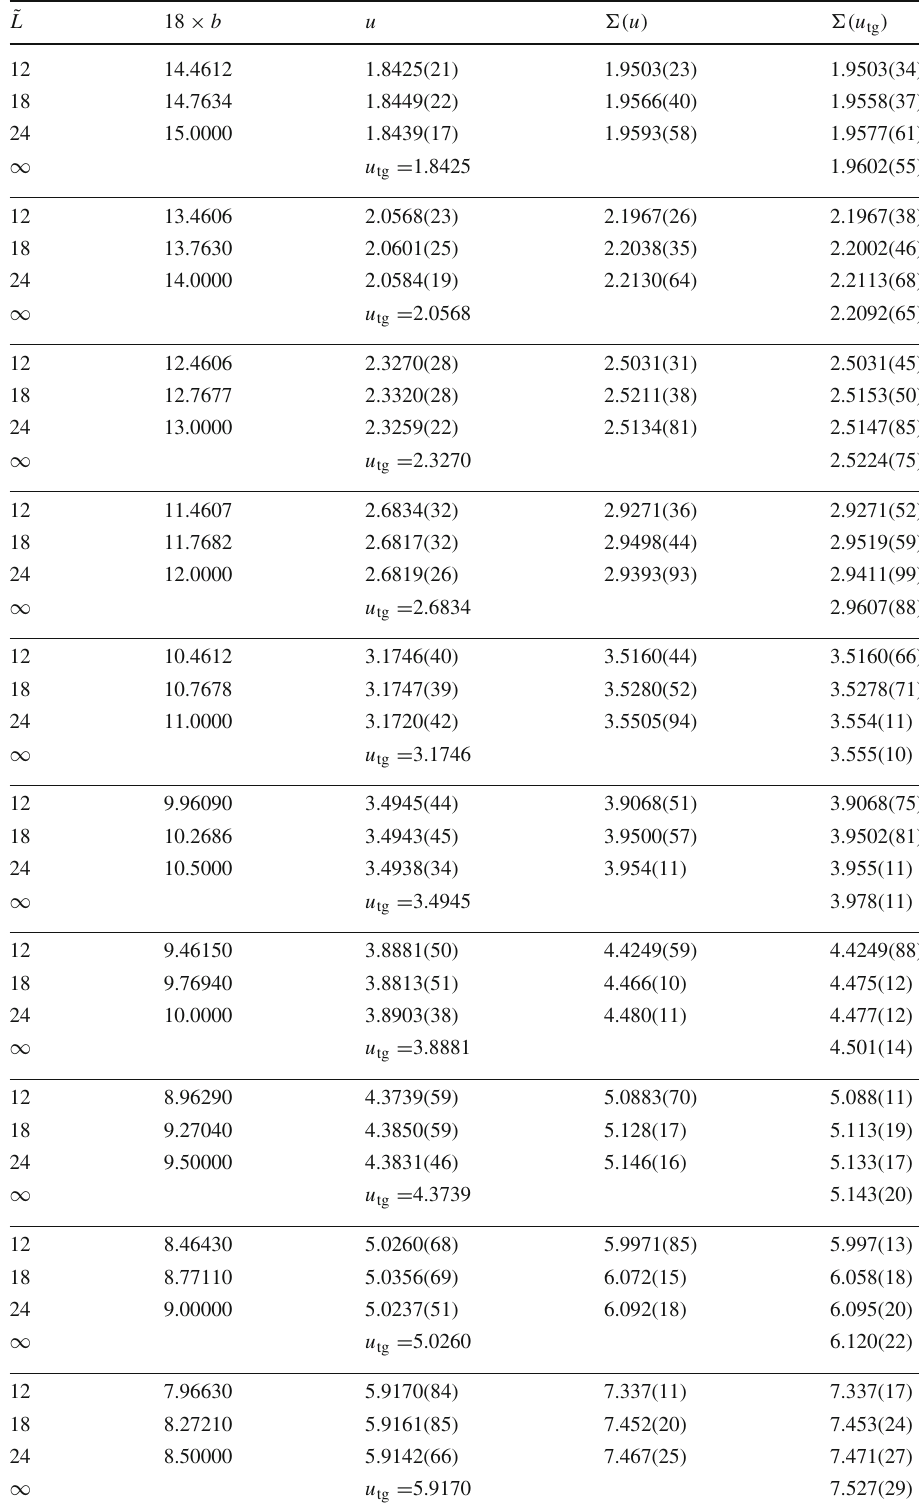
Table 8 Raw data for the lattice step scaling function (cid:13)( u ) at the values of u tuned for the u -by- u continuum extrapolation – see Sect. 3.2.1. The small mismatch in fixing the value of u is corrected for by slightly shifting the lattice step scaling functions to a constant value u tg , leading to the values (cid:13)( u tg ) given in the table. We also give the continuum step scaling function obtained from the continuum extrapolations displayed in Fig.